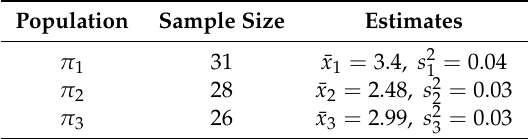
Table 6. Sample mean and variance for the three groups of grade point average (GPA)